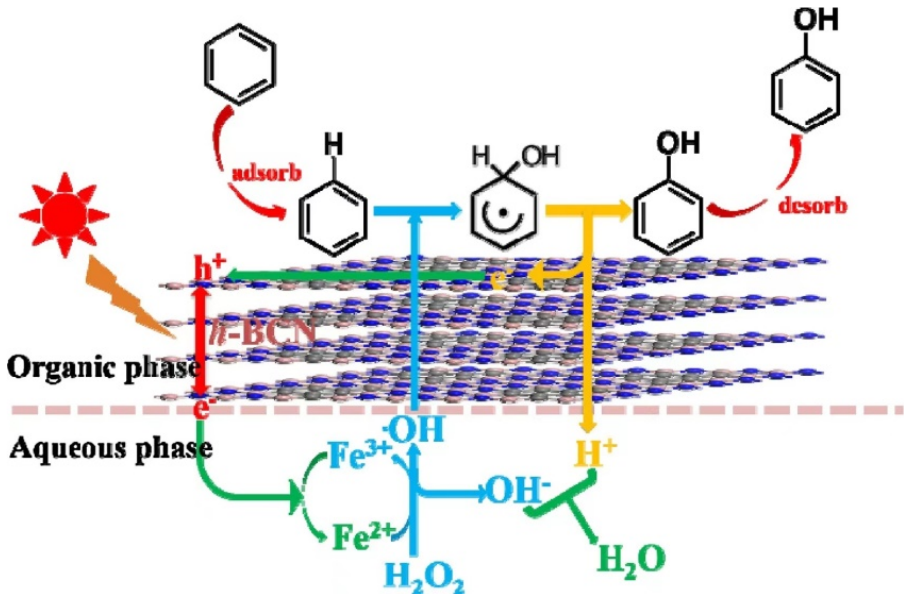
Figure 5. Reaction mechanism of photocatalytic hydroxylation of benzene by h-BCN combined with FeCl 3 . Reprinted with permission from Ref. [88]. 2019 Elsevier.